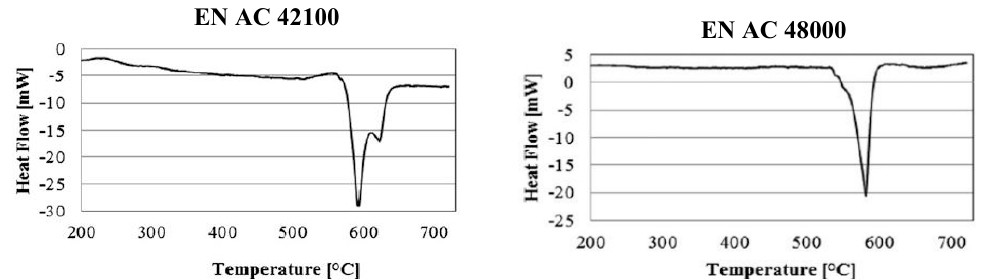
Figure 1. Differential Scanning Calorimetry (DSC) analysis [10].